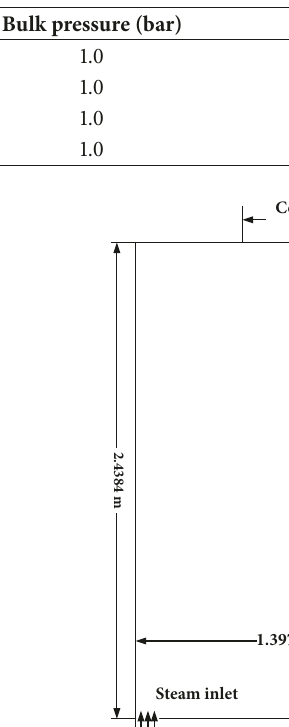
Table 1: Conditions of the simulated AP600 containment atmospheric experiments.